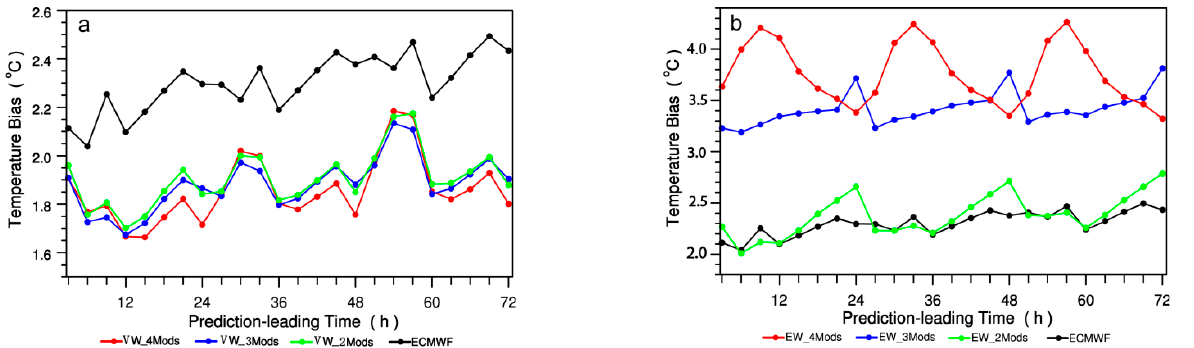
Figure 6. Averaged variations of 2 m temperature prediction RMSEs (units: ◦ C) over 2380 surface stations of China in October 2015 with respect to the prediction leading times for the 2, 3 and 4 models ensemble forecasting using ( a ) VW and ( b ) EW ensemble methods compared with that of the ECMWF forecasting. The specific models taken for the 2-, 3- and 4-models ensemble forecasting are shown in Table 1.